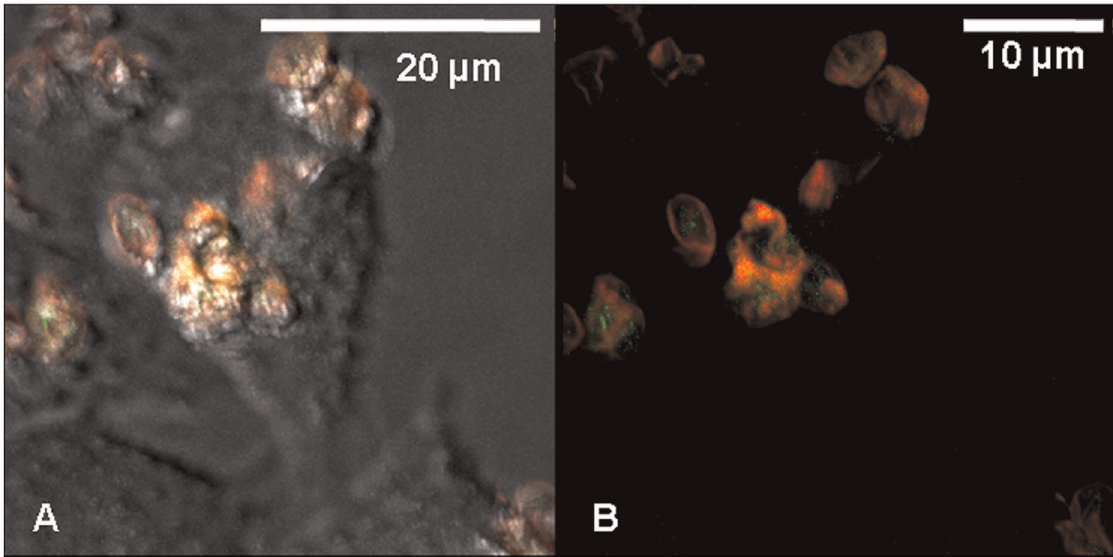
Figure 9. CLSM images showing the characteristic emission of Tb 3 + from the HeLa cell internalized LaF 3 :Tb 3 + (5%) nanoparticles- loaded PSS/RITC-PAH capsule. (a) Composite image of bright field and fluorescent signals arising from LaF 3 :Tb 3 + (5%) nanoparticles (green emission from Tb 3 + ) and RITC-PAH (red); and (b) composite image of fluorescent signals arising from LaF 3 :Tb 3 + (5%) nanoparticles (characteristic green emission from Tb 3 + ) and RITC-PAH (red) showing internalized LaF 3 :Tb 3 + (5%) nanoparticles-loaded capsules.